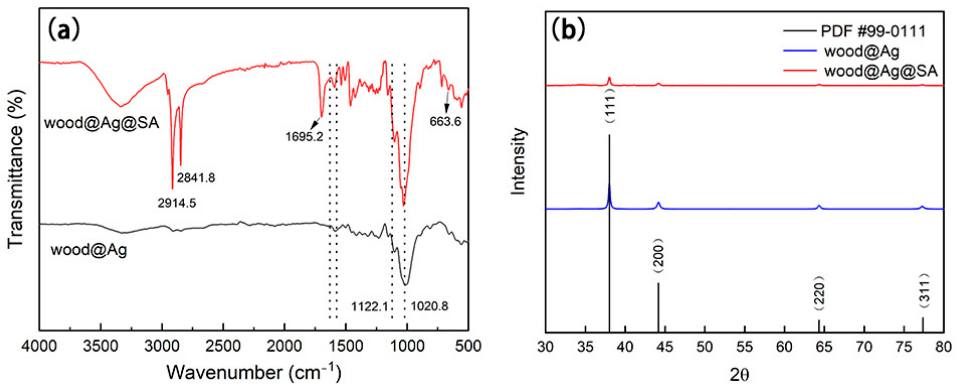
Figure 1. The infrared spectra ( a ) and X-ray diffraction spectra ( b ) of wood@Ag and wood@Ag@SA.